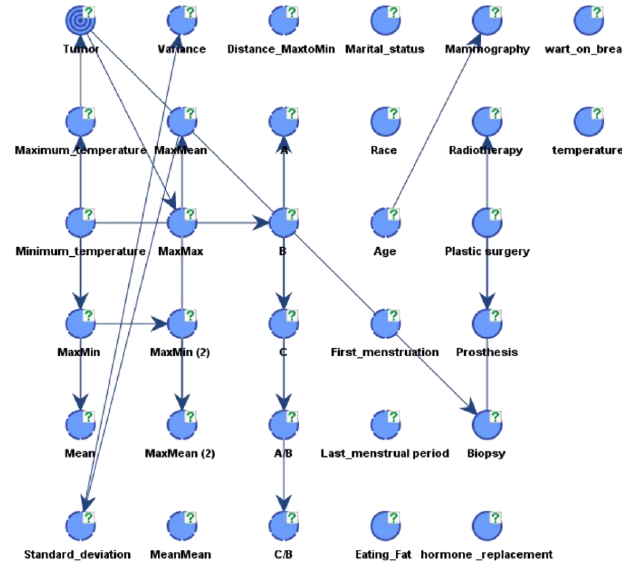
Figure 7. BN with influences from unsupervised learning. Table 5. Summary of performance indices of BN model.